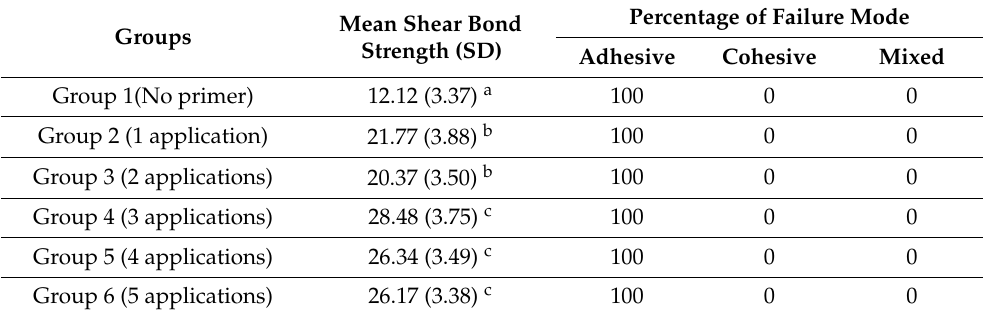
Table 2. Mean shear bond strength, standard deviation (MPa) and percentage of failure mode.